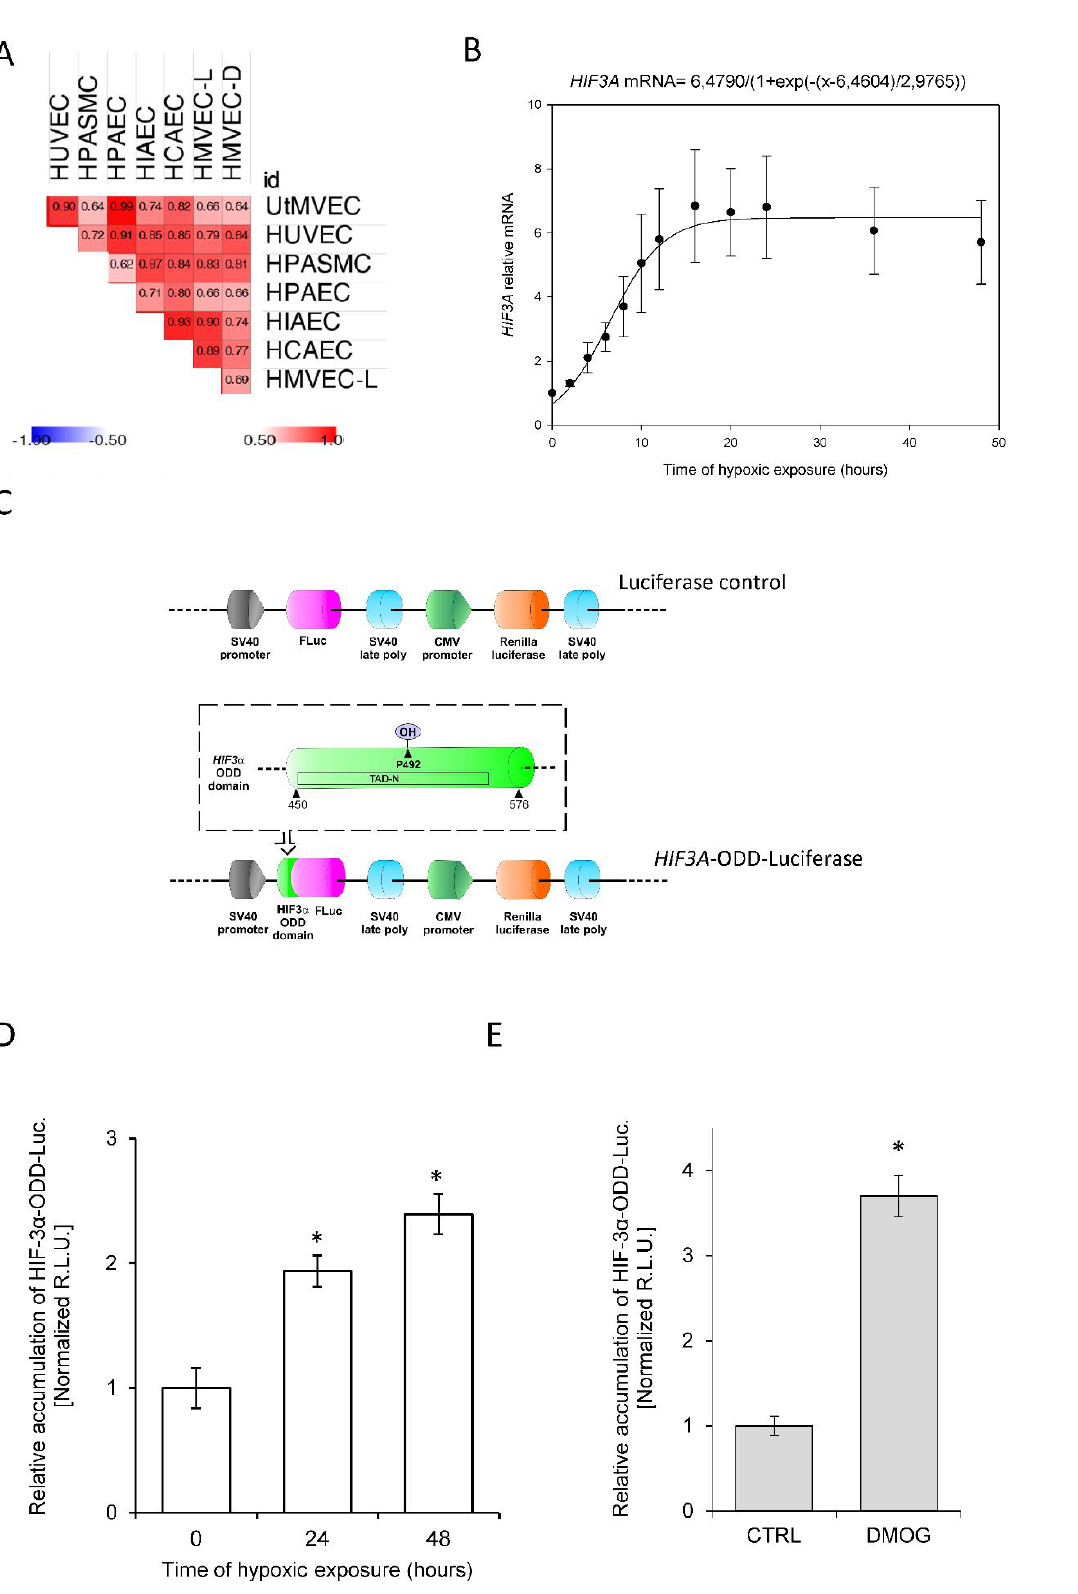
Figure 4: Hypoxic accumulation of HIF-3α results from both increased expression and prolyl hydroxylase inactivation in HUVECs. (A ) The Spearman’s correlation of the hypoxia induced- HIF3A mRNA level changes in different human ECs. ( B ) The mathematic representation of HIF3A mRNA levels during hypoxia in human ECs. The changes in mRNA levels obtained from all ECs tested during the hypoxia time course were analyzed The changes in HIF3A levels in HUVECs during hypoxia time